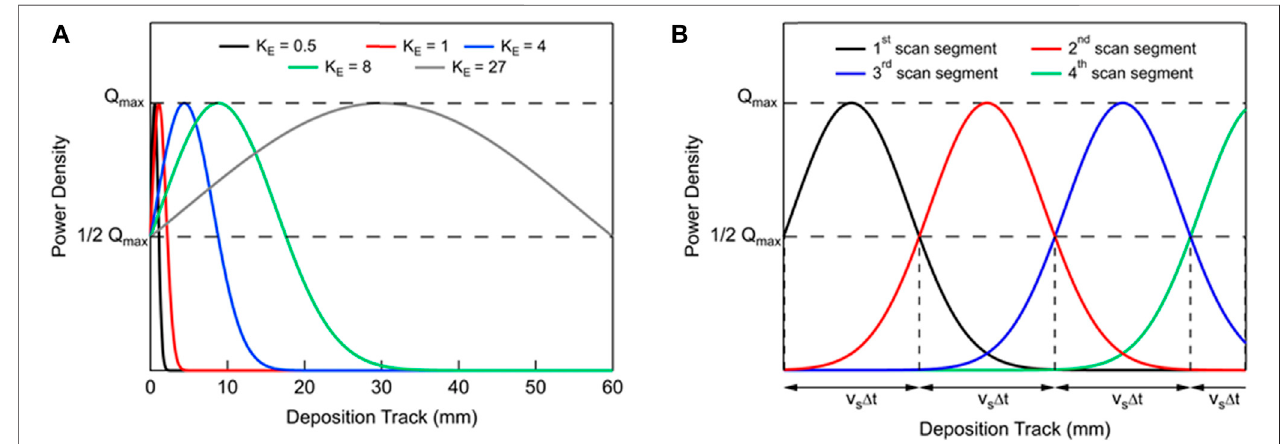
FIGURE 8 | (A) Illustration of K E (sub-track sizes) at fi rst computation time step of Elongated Ellipsoid (EE) heat Source, (B) Power Intensity for subsequent sub- tracks of elongated ellipsoid (EE) with K E (cid:2) 8 over the deposition track.